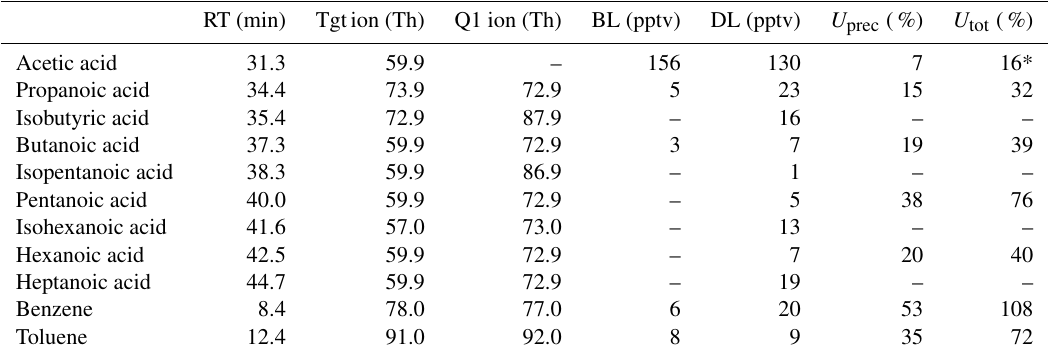
Table 1. Retention times (RT), ions used for the quantitation (Tgtion) and qualitation (Q1 ion), blank values (BL), detection limits (DL), precision ( U Prec ) and total expanded uncertainties ( U tot ) for studied compounds at mean ambient air mixing ratios during the measurement campaign at SMEAR II in June